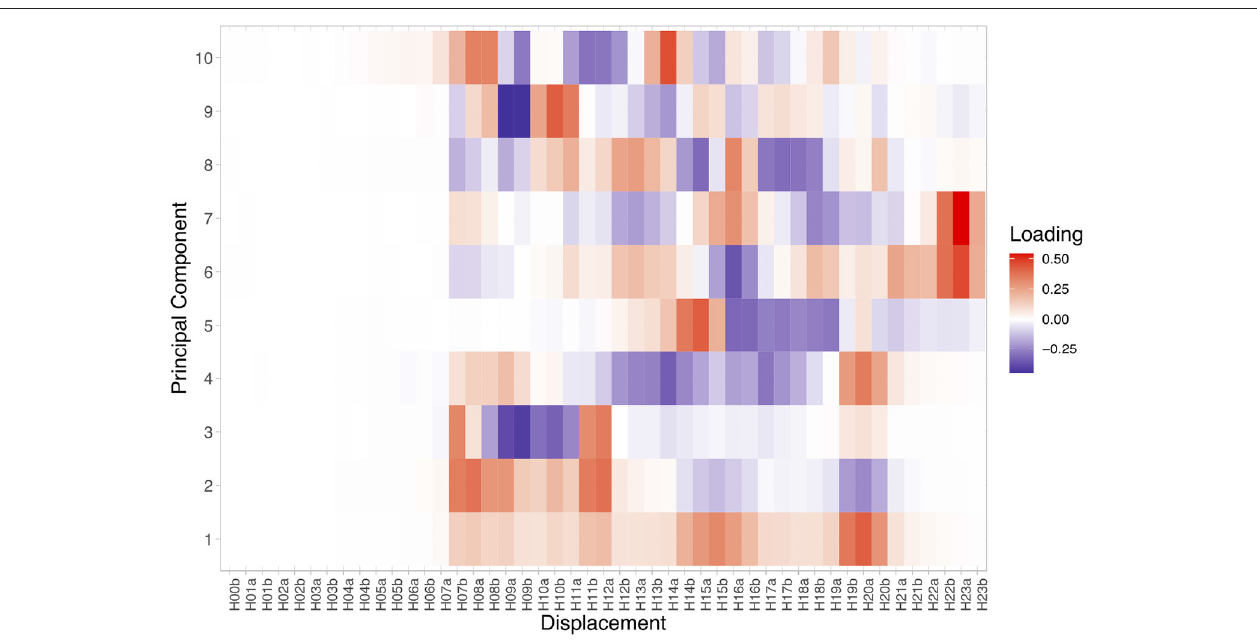
FIGURE 2 | Loadings of the first 10 Principal Components of our participants’ Daily Displacement Profiles. Labels on the horizontal axis are the same as Figure 1 and indicate the GPS displacement associated with each half-hour segment compared to the previous one. Cell color indicates the sign of a particular variable in relation to a PC. Red indicates that a specific PC is in the same direction as a variable whereas blue indicates that it is the opposite. Darker color (red or blue) indicates loadings with a greater absolute